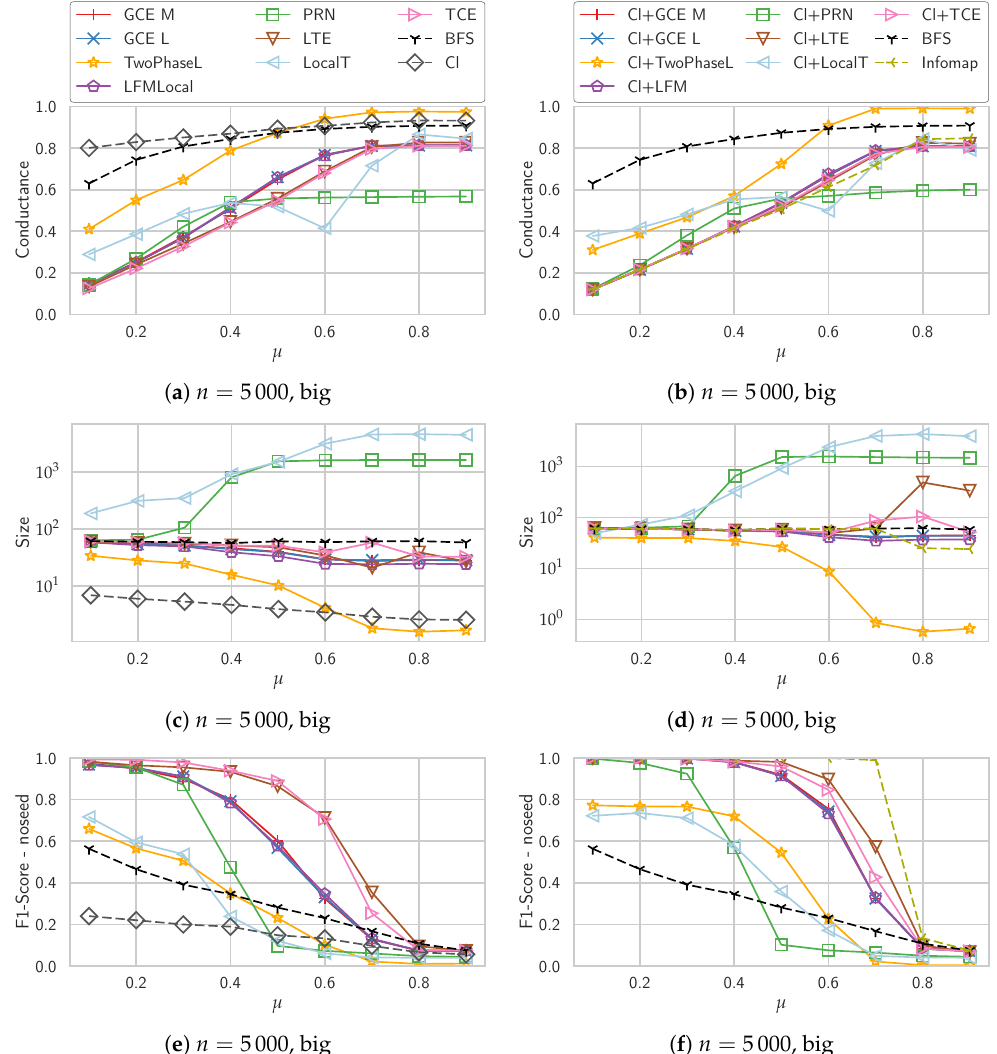
Figure 2. Different measures for the 5000 node unweighted graph with disjoint big